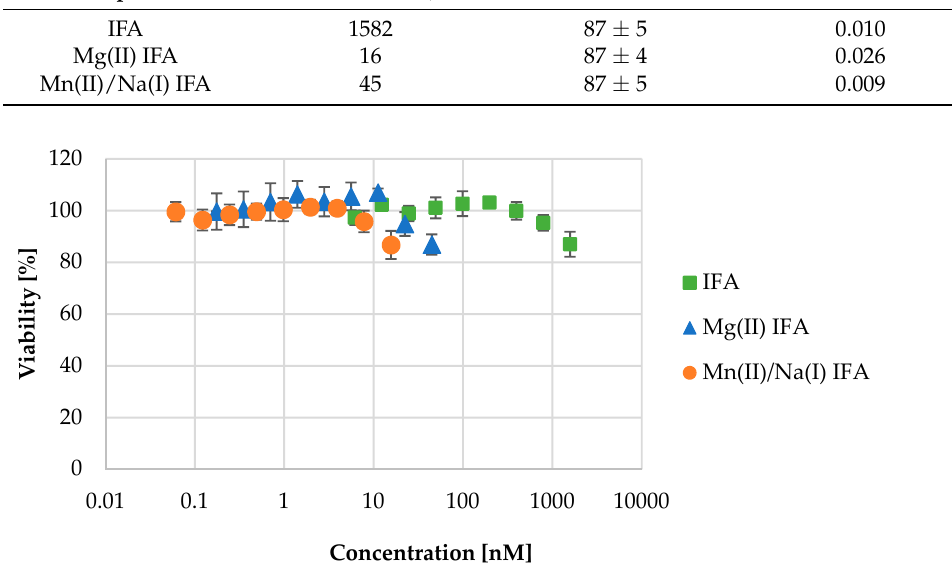
Figure 10. Cell viability assay test results for IFA (0–1.582 µ M), Mg(II) IFA (0–45 µ M), and Mn(II)/Na(I) IFA (0-16 µ M). The error bars represent standard deviation values.